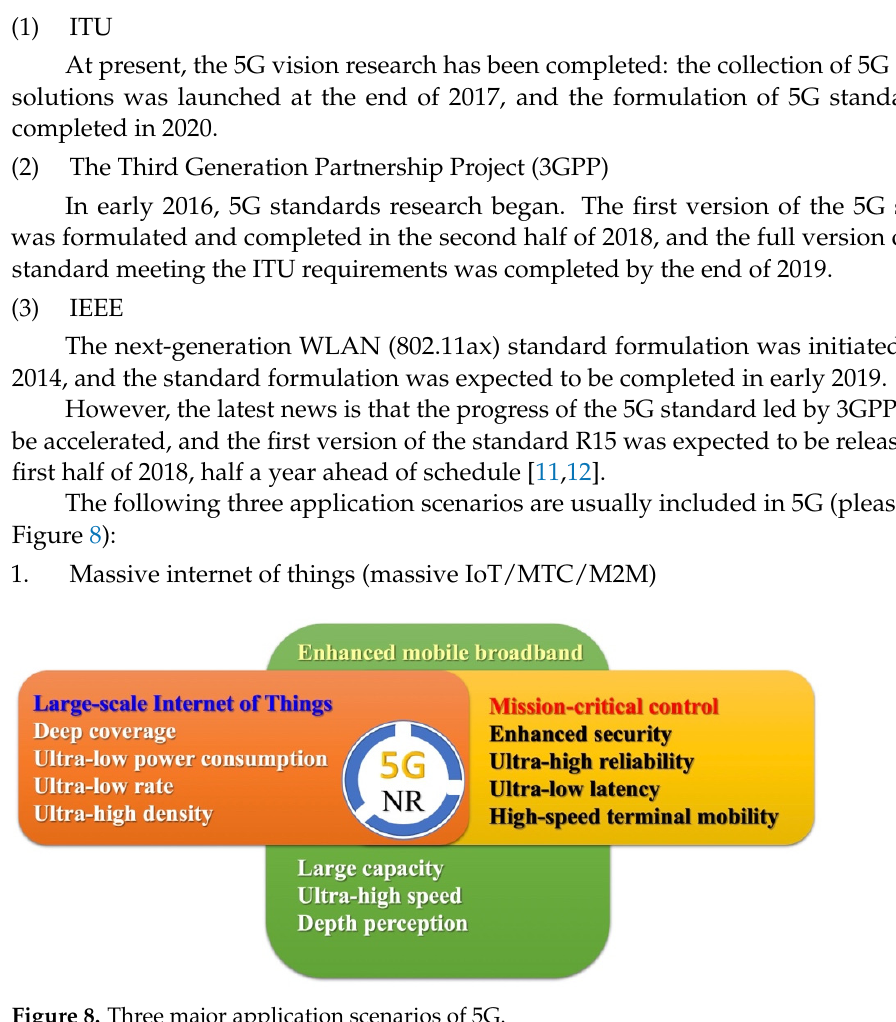
Table 2. Fifth generation (5G) New radio interface KPI indicators.